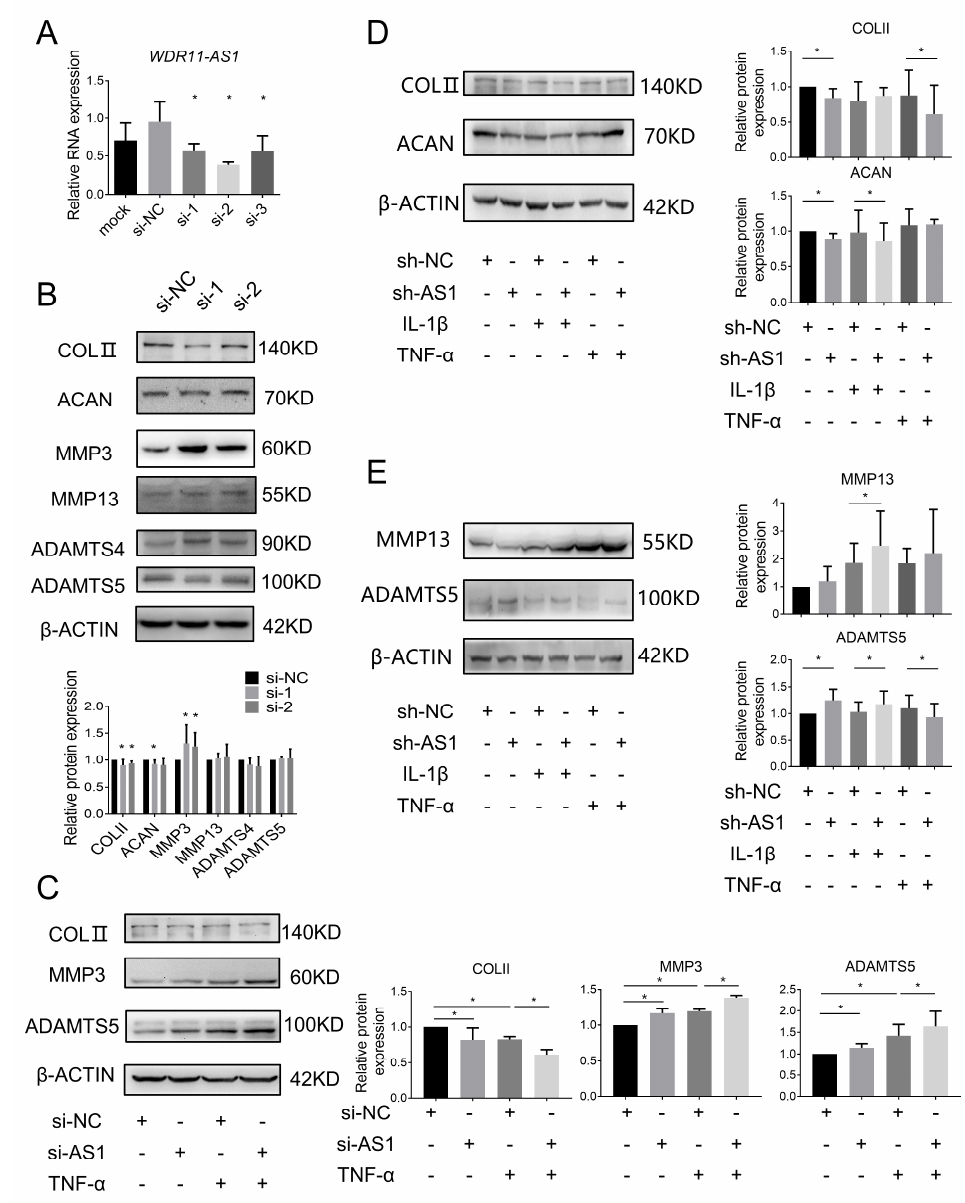
Figure 2. Inhibition of lncRNA WDR11-AS1 promotes ECM degradation in chondrocytes. ( A ) Expression of lncRNA WDR11-AS1 was determined by RT-qPCR in SW1353 cells transfected with three siRNAs (50 nM) targeting endogenous WDR11-AS1. ( B ) Western blot analysis showed COLII, ACAN, MMP3, MMP13, ADAMTS4, and ADAMTS5 protein levels in SW1353 cells after WDR11-AS1 knockdown. ( C ) Western blot analysis showed COLII, MMP3, and ADAMTS5 protein levels in TNF- α (10 ng/mL)-stimulated SW1353 cells after WDR11-AS1 knockdown. ( D , E ) Western blot analysis showed COLII, ACAN ( D ), MMP13, and ADAMTS5 ( E ) protein levels in IL-1 β or TNF- α (10 ng/mL)-stimulated primary chondrocytes after WDR11-AS1 knockdown. * p < 0.05, si-RNA vs. si-NC ( A , B ); the measurement data are expressed as the mean ± standard deviation, and were analyzed by Mann-Whitney U test. The experiments were repeated three